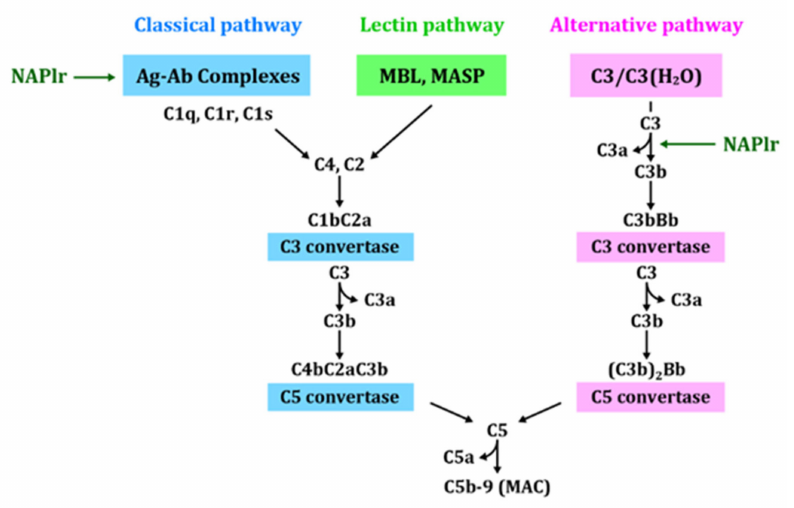
Figure 15. Schematic representation of the complement activation through each pathway and NAPlr. Ag-Ab: antigen-antibody, MBL: mannose-binding lectin, MASP: mannose-binding lectin-associated serine proteases, C3(H 2 O): hydrolyzed C3, MAC: membrane attack complex, NAPlr: nephritis- associated plasmin